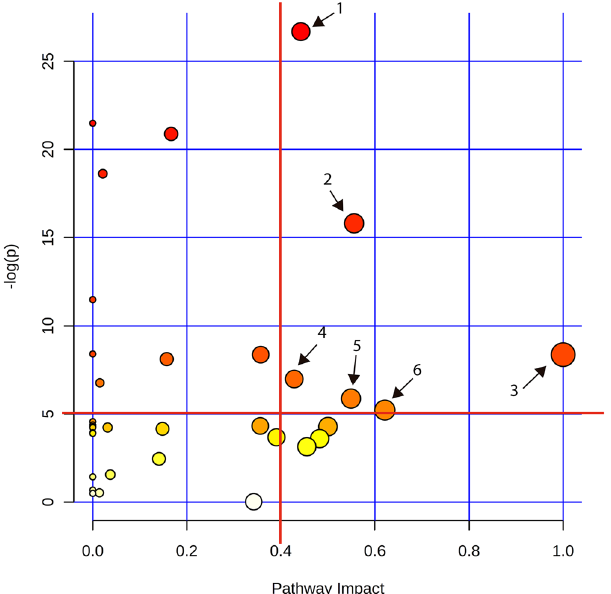
Figure 5. Metabolic pathway analysis based on plasma amine profiles in pigs fed a BSF or SBM based diet. The graph represents the result of the metabolic pathway analysis. Scores from the topology analysis on the ‘x axis’ and from the enrichment analysis are represented on the ‘y axis’. The size and the color (on gradient scale: white to red) of the nodes are all matched pathways according to the p values from the pathway enrichment analysis and pathway impact values from the pathway topology analysis. The red lines denote the thresholds in both axes to identify the most significant matched pathways for all the dietary comparisons. The arrow indicates to the enriched pathways, where, 1 is cysteine and methionine metabolism; 2 is glycine, serine and threonine metabolism; 3 is phenylalanine, tyrosine and tryptophan biosynthesis; 4 is taurine and hypotaurine metabolism; 5 is histidine metabolism and 6 is alanine, aspartate and glutamate